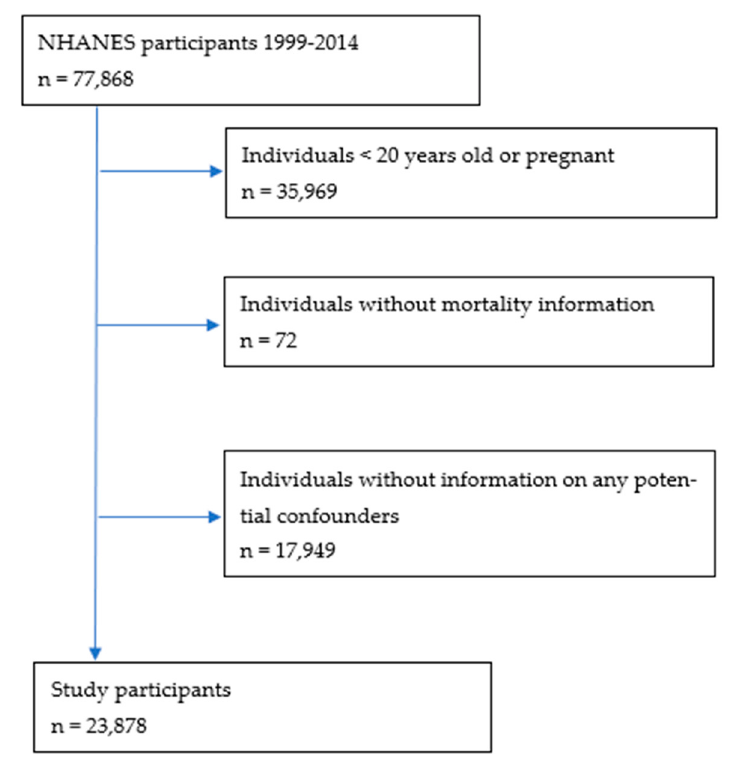
Figure 1. Participant flowchart.